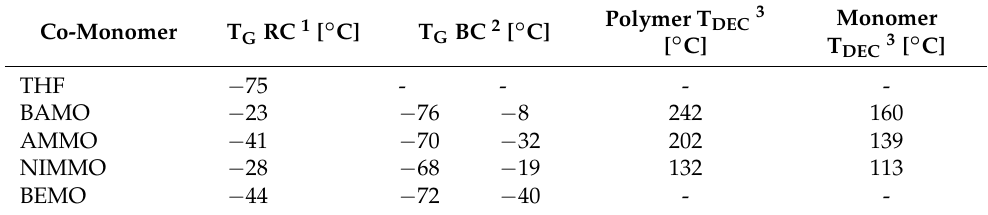
Table 4. Glass transition (T G ) and decomposition temperatures (T DEC ) of random and block copoly- mers of THF and selected energetic oxetanes. Reprinted with permission of John Wiley & Sons from